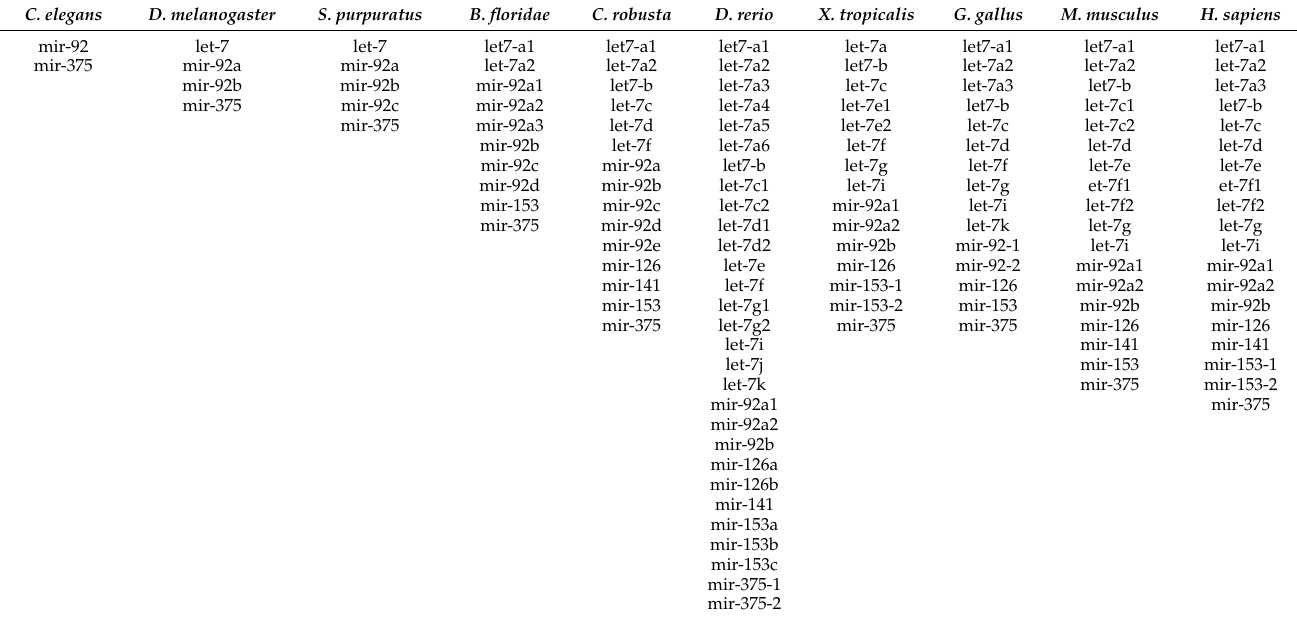
Table 3. Evolution pattern of conserved